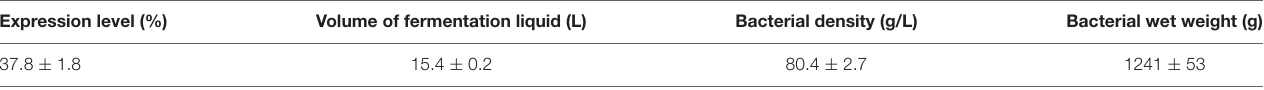
TABLE 2 | Summary of fermentation data of rhaFGF 135 at the scales of 30-L tank ( n = 3). Expression level (%) Volume of fermentation liquid (L) Bacterial density